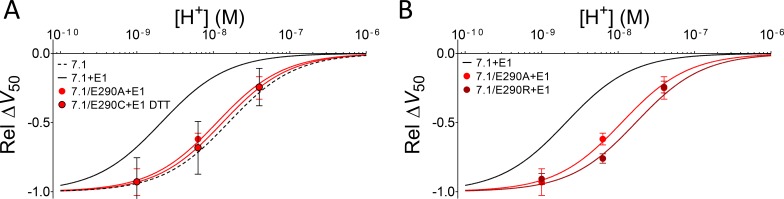
Alternative substitutions at position 290 support the hypothesis that the negative charge at position 290 is important for DHA protonation in the presence of KCNE1.(A) pH dependence of the DHA effect (70 µM) on the relative ΔV50 for KV7.1/E290A + E1 and KV7.1/E290C + E1 in the presence of DTT (0.5 mM DTT was added to the incubation solution and control solution to prevent disulphide bond formation during oocyte incubation and experiment). Data shown as mean ± SEM. n = 4–7 for each data point. Fit for KV7.1+E1 (solid black line) and KV7.1 alone (black dashed line) are shown for comparison. Best fit with Equation 2: pKa = pH 8.0 for KV7.1/E290A + E1, and 7.9 for KV7.1/E290C + E1 in DTT. (B) pH dependence of the DHA effect (70 µM) on the relative ΔV50 for KV7.1/E290A + E1 and KV7.1/E290R + E1. Data shown as mean ± SEM. n = 3–7 for each data point. Fit for KV7.1+E1 (solid black line) is shown for comparison. Best fit with Equation 2: pKa = pH 8.0 for KV7.1/E290A + E1, and 7.7 for KV7.1/E290R + E1.